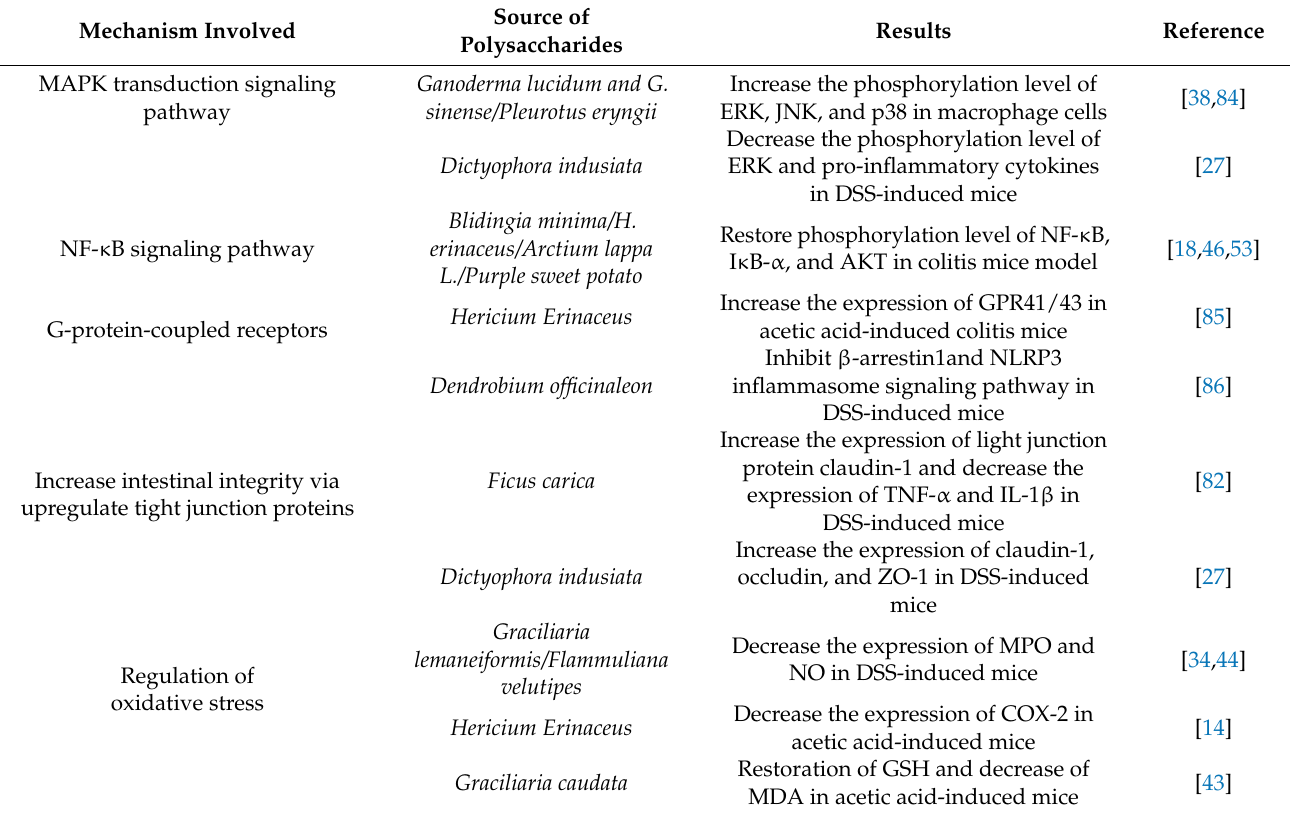
Figure 1. The effects of natural polysaccharides on IBD. Table 2. The mechanisms of natural polysaccharides involved in colon inflammation amelioration.